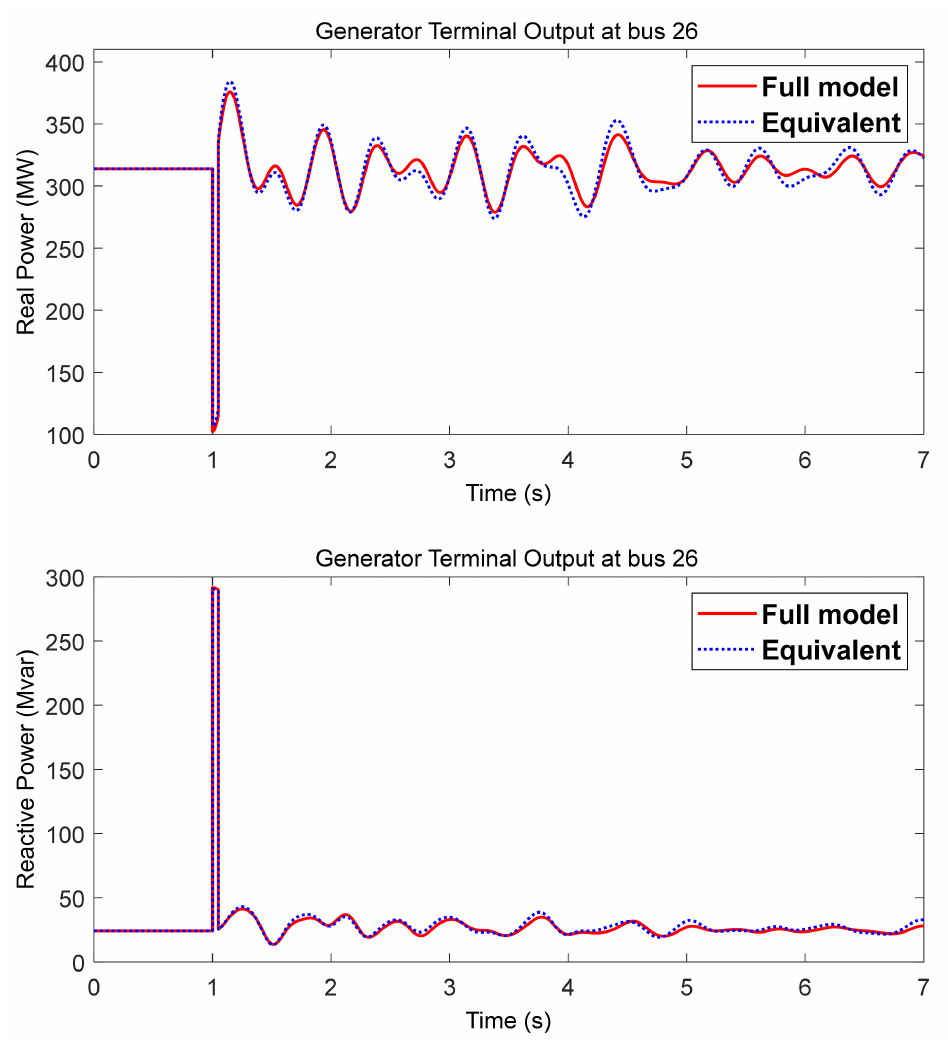
Figure 8. Real and reactive power comparisons of Gen #26 with bus-to-ground fault at bus